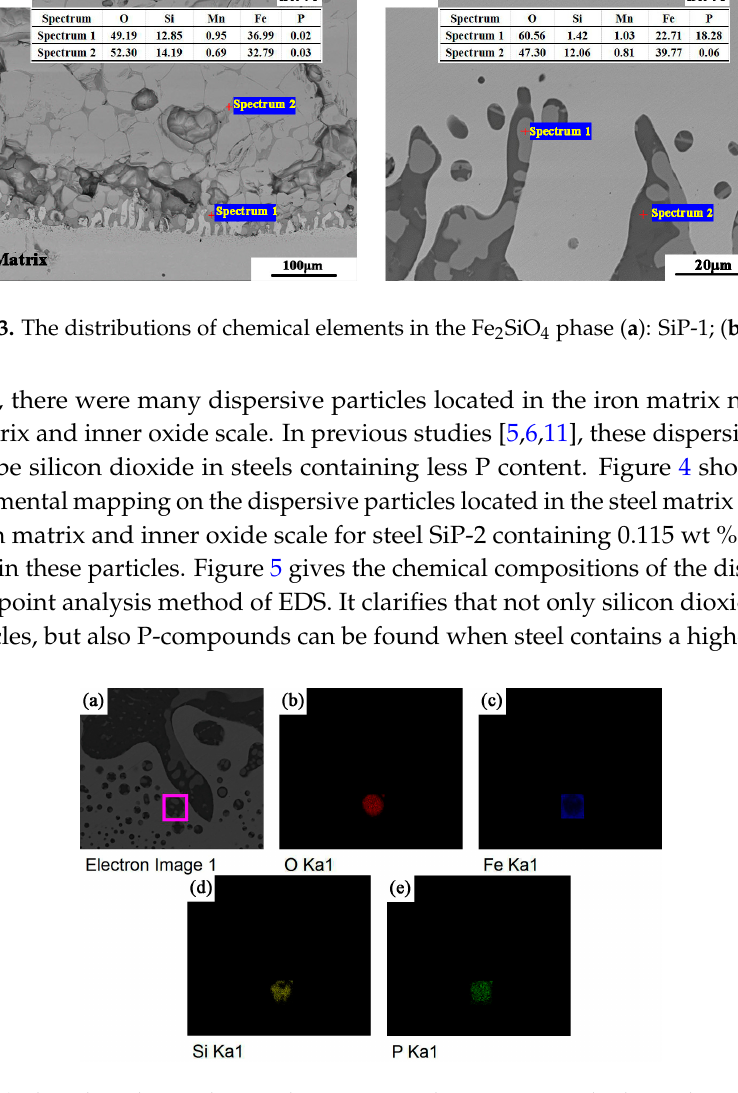
Figure 4. ( a – e ) The selected-area elemental mapping on dispersive particles located near the interface between the matrix and inner oxide scale.